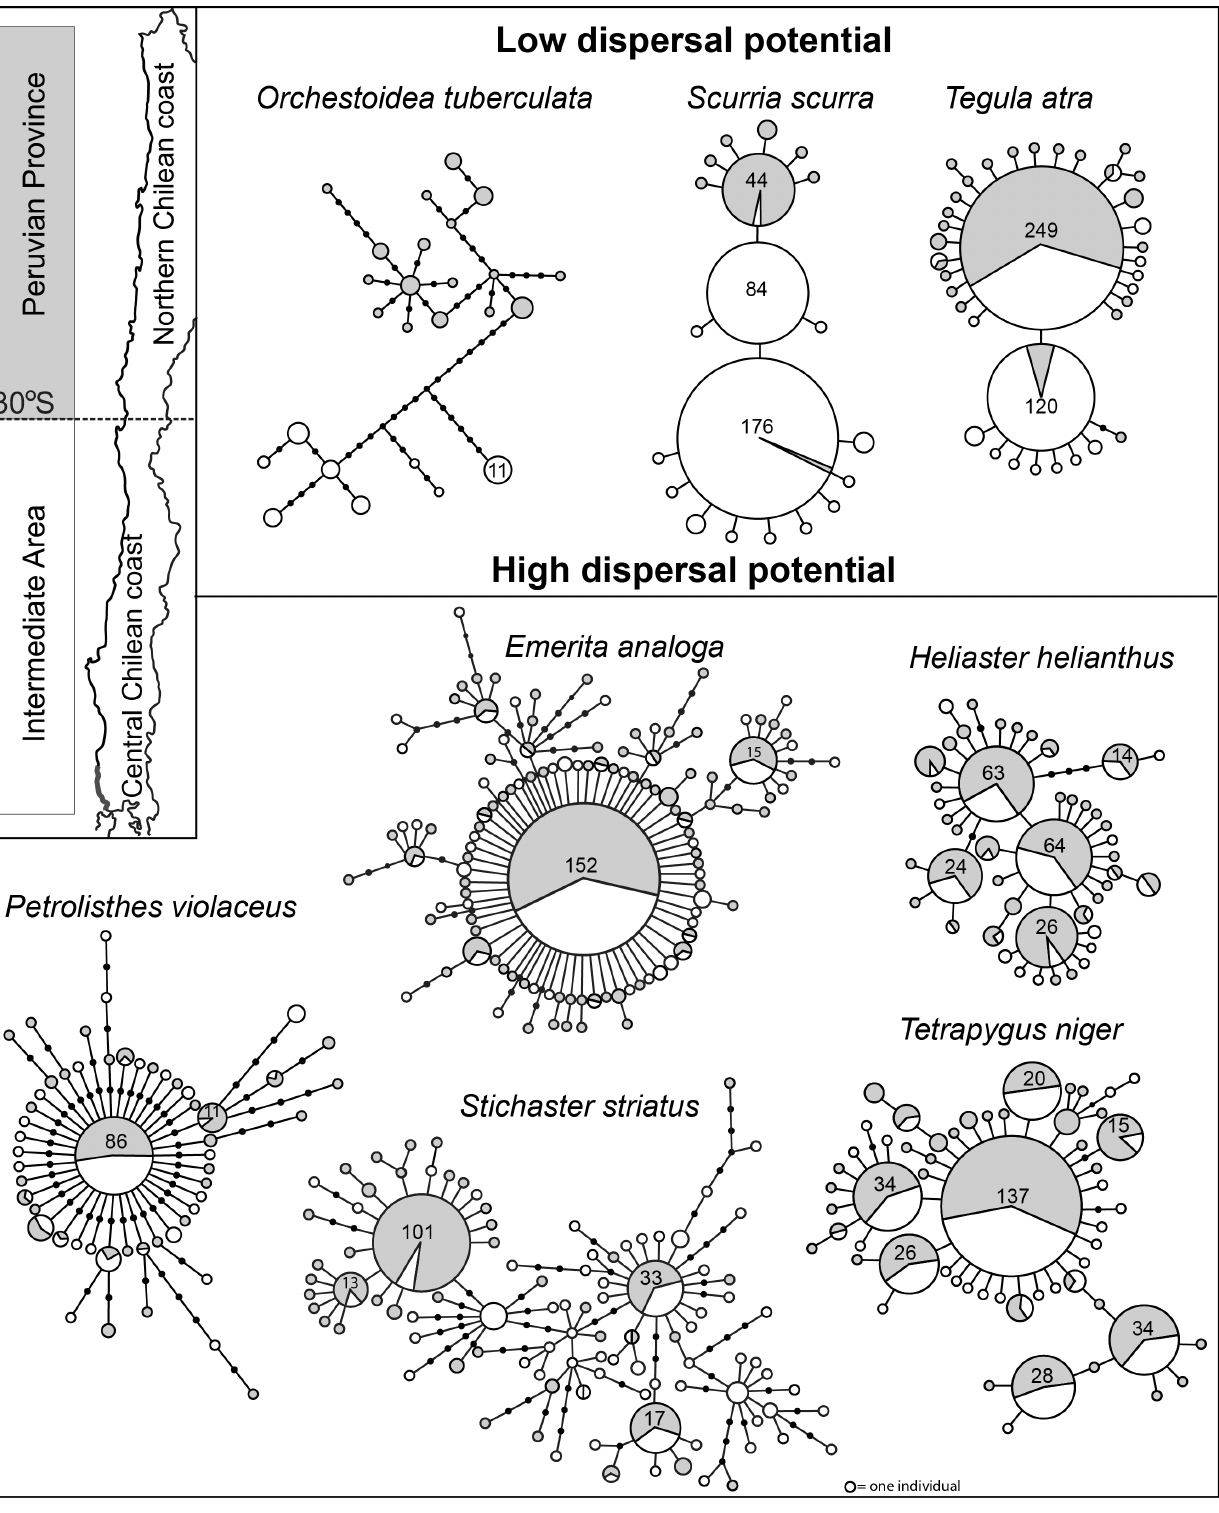
Figure 4. Median joining haplotype networks of eight species analyzed of the Chilean coast. Insert with map details the biogeographic regions north and south of 30 u S in the analyzed coast section and shades associated with each of them that were used to mark the geographic location of haplotypes. All haplotype networks are standardized in such way that small circles represent haplotypes present in one individual. Mutational steps (lines between circles) were kept the same length excepting for the network of Emerita analoga where mutational steps arising from the most common haplotype were kept to the minimum length to allow accommodating all derived haplotypes.